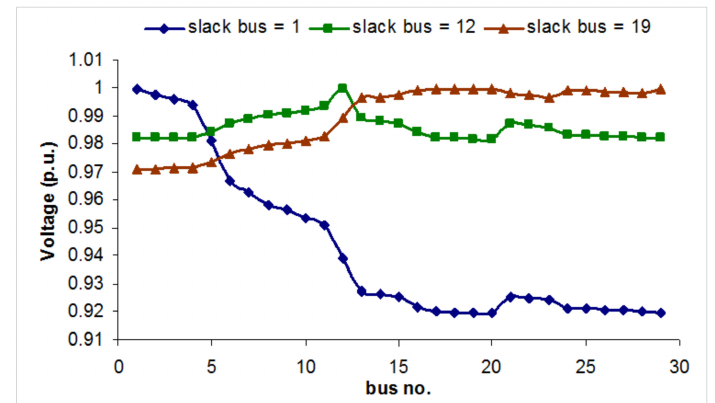
Figure 13. Variation of voltage profile with location of PV system for a load of 5 kW.